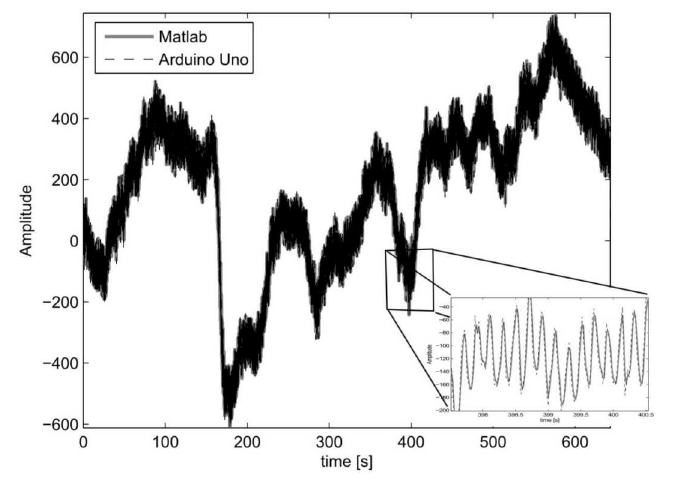
Figure 5. Filtering result comparison of the implementation of the Oustaloup time-domain approximation and Matlab-Simulink for